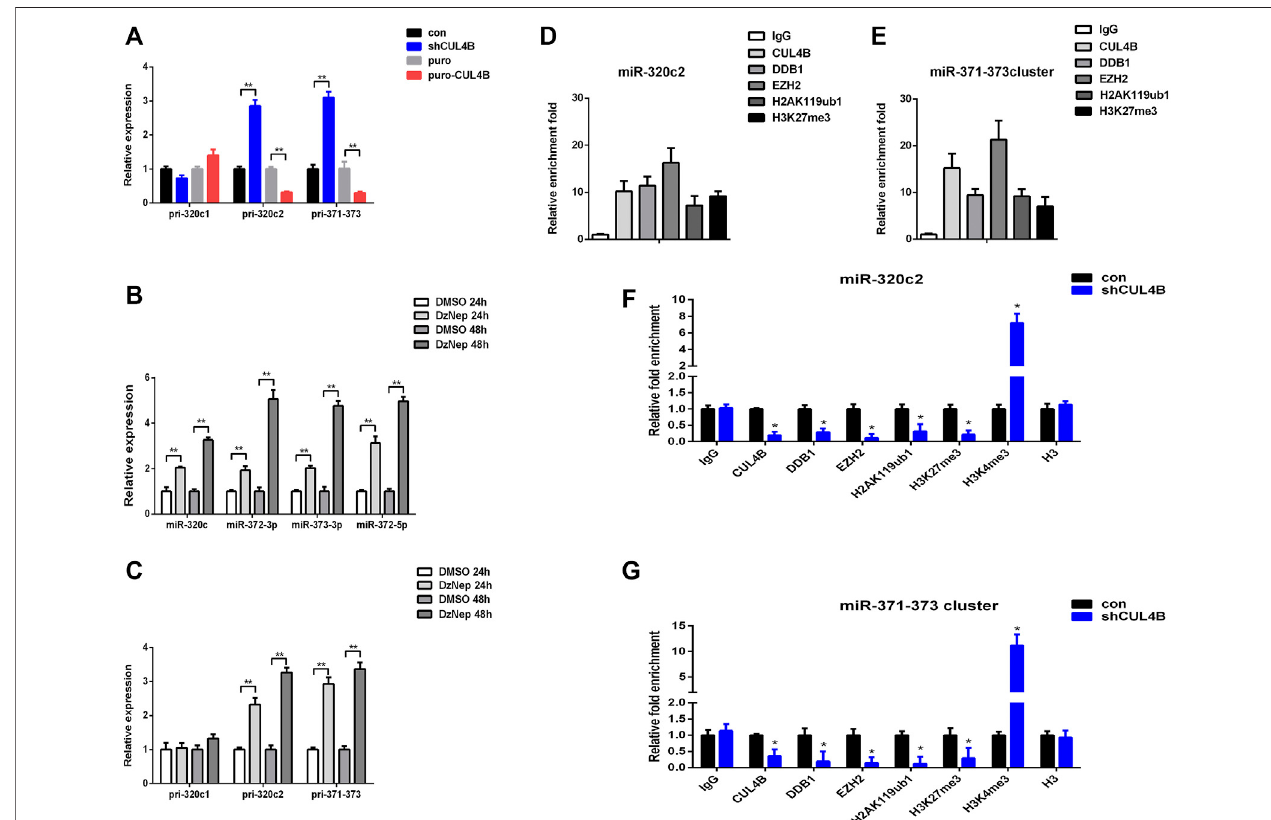
FIGURE 5 | CUL4B epigenetically represses the expression of miR-320c/miR-371 – 373 in PDLSCs. (A) pri-miR levels in CUL4B stable overexpressing (puro- CUL4B)andknockdown(shCUL4B)PDLSCstogetherwiththecorrespondingcontrolcells(conorpuro)wereanalyzedbyqRT-PCR. (B,C) miRNAandpri-miRNAlevels inPDLSCstreatedwith1 µMDzNepfor24and48 hdeterminedbyqRT-PCR. (D,E) ChIPassaysperformedusingPDLSCswithantibodiesagainstIgG,CUL4B,DDB1, EZH2, H2AK119ub and H3K27me3. qRT-PCR was performed with primers at the region of miR-320c (D) and miR-371 – 373 (E) promoter. (F,G) ChIP assays performed in CUL4B stable knockdown (shCUL4B) PDLSCs together with the corresponding control cells (con) with antibodies against CUL4B, DDB1, EZH2, H2AK119ub, H3K27me3, H3K4me3, and Histone H3. qRT-PCR was performed with primers at the region of miR-320c (F) and miR-371 – 373 (G) promoters. All quanti fi cation analyses were based on independent triplicate experiments. Error bars represent SD. Statistical comparisons were made using a two-tailed unpaired t-test, * p < 0.05, ** p < 0.01 compared with the negative control.